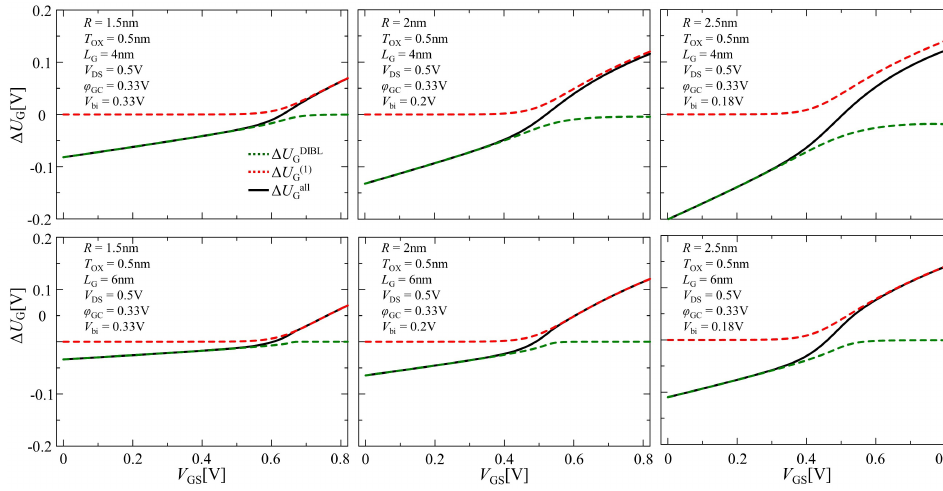
Figure 5. Comparison of the results of ∆ U all